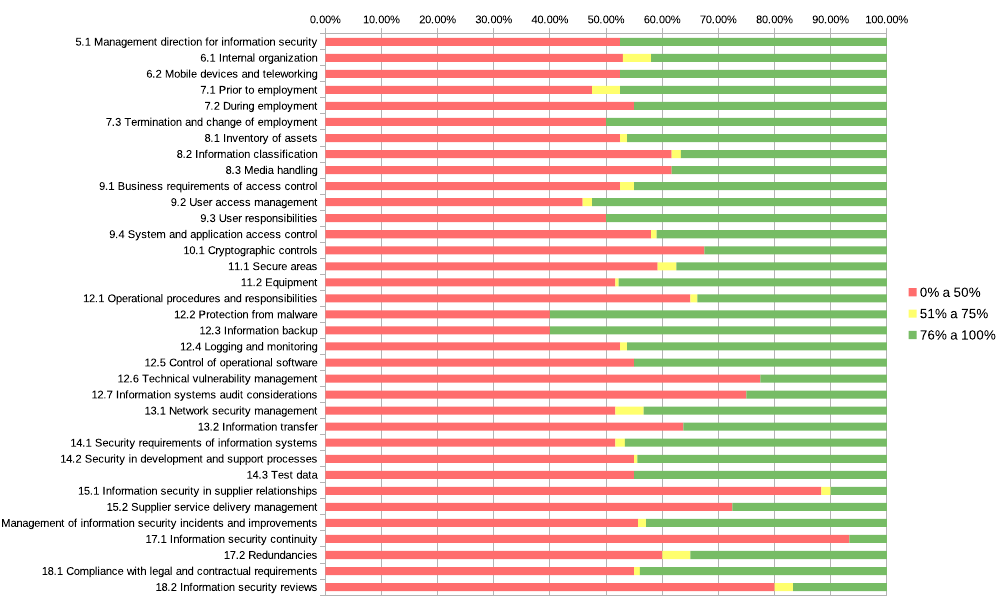
Figure 6. Type 2—Cumulative Acceptance Percentage of ISO-27001:2013 standard sections, by intervals—First Auditing.